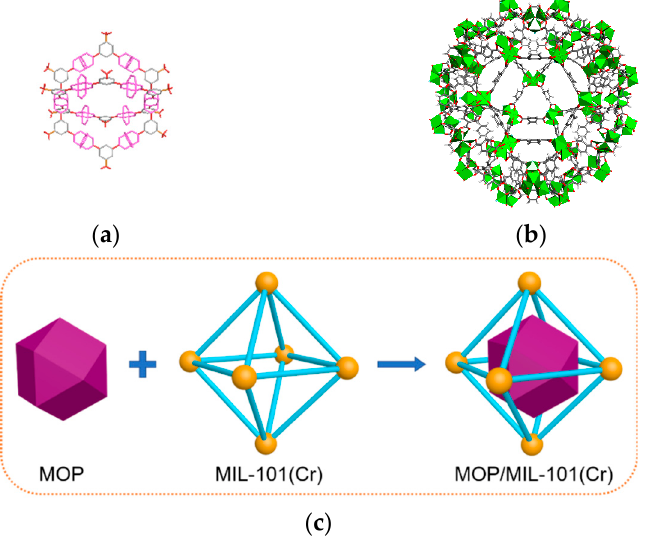
Figure 1. Structure of ( a ) MOP 3 and ( b ) MIL-101(Cr). ( c ) The schematic illustration of construction for MOP/MIL-101(Cr).